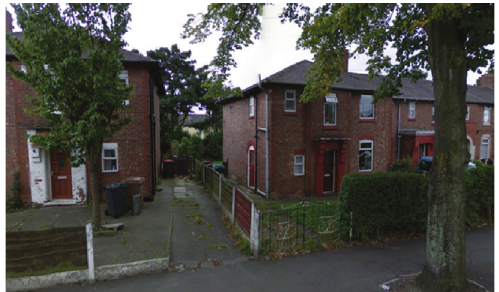
Figure 3: City West Housing Trust “environmental” scheme before works. Source : author.